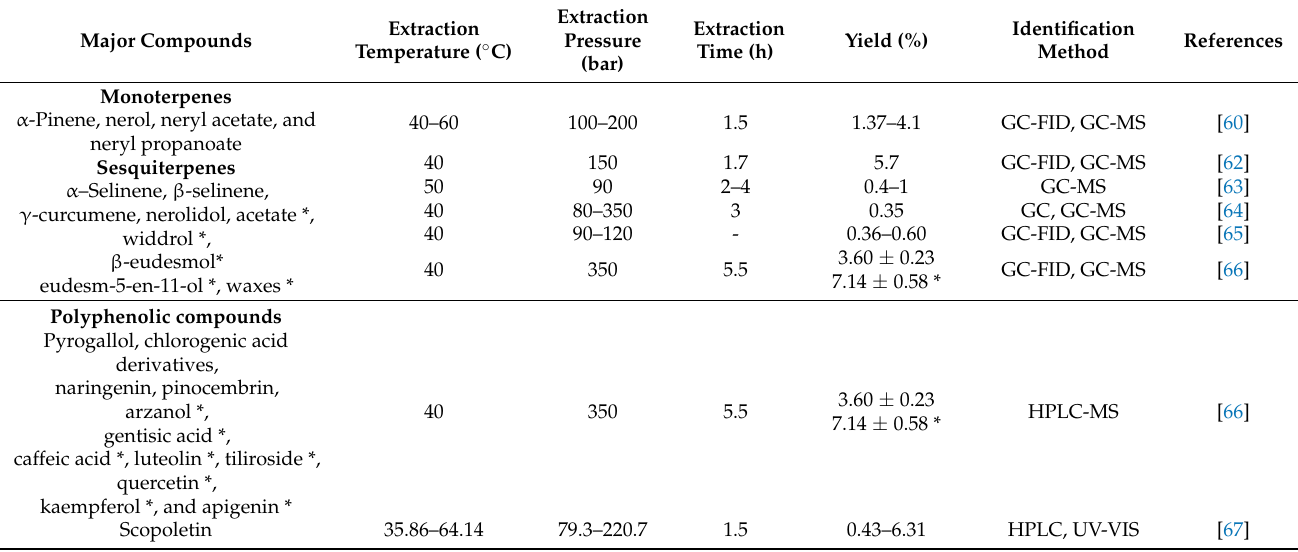
Table 2. Overview of Helichrysum italicum major bioactive compounds obtained by supercritical CO 2